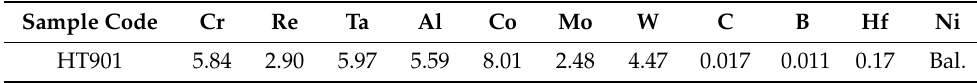
Table 1. Chemical composition of single crystal sample (wt%).